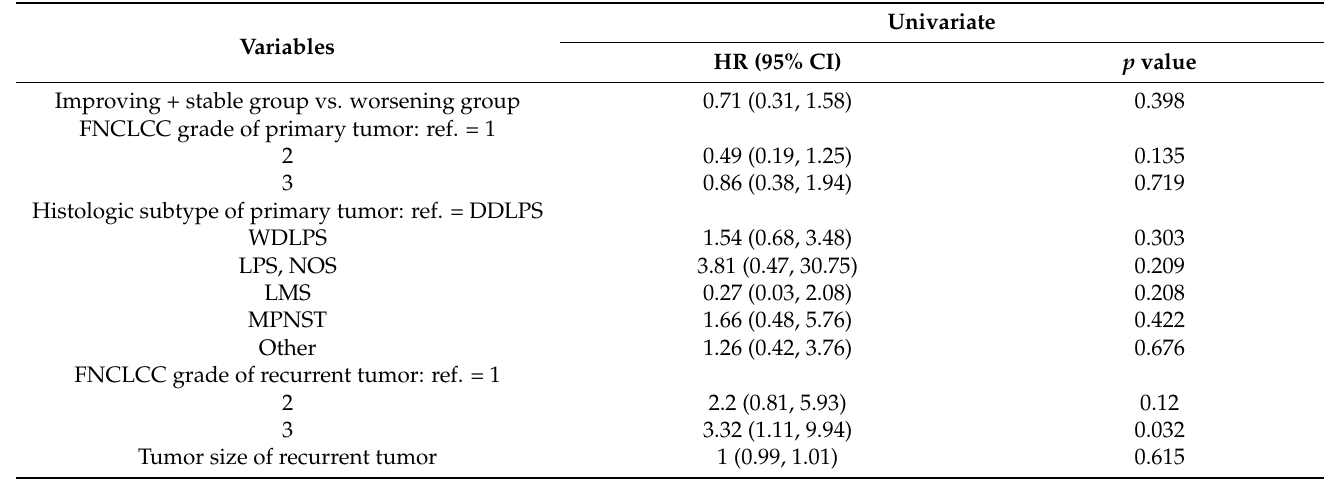
Table 4. Univariate analysis of risk factors associated with second local